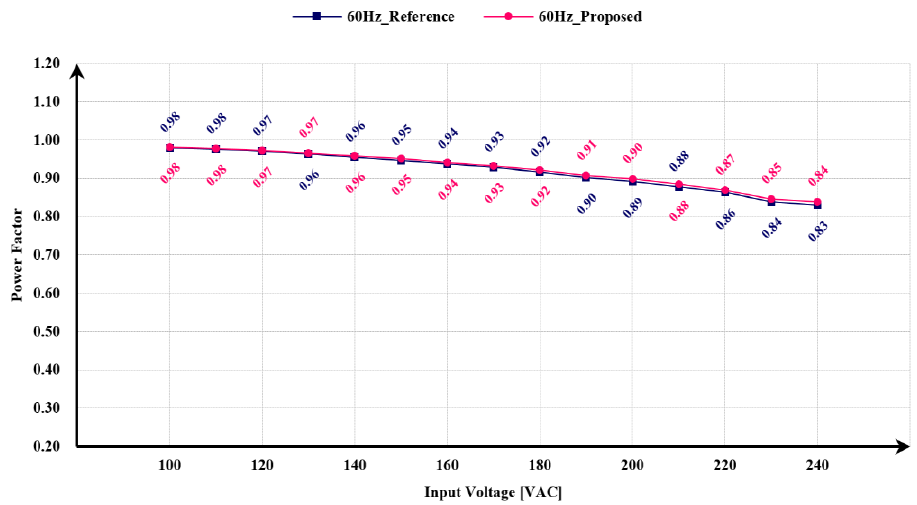
Figure 10. PF at 60 Hz. Figure 10. PF at 60